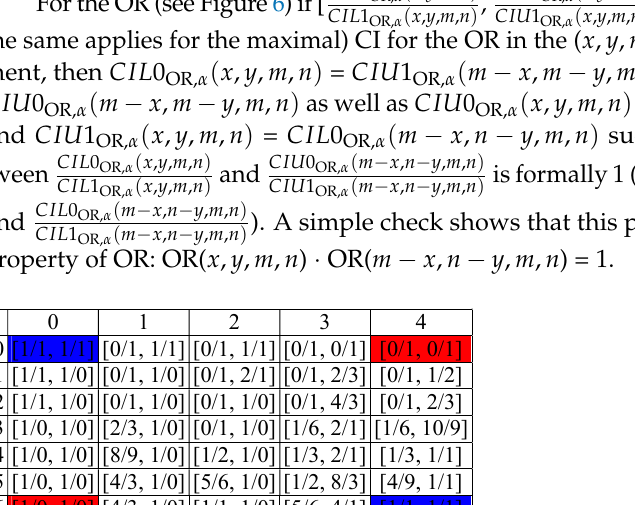
For the OR (see Figure 6) if [